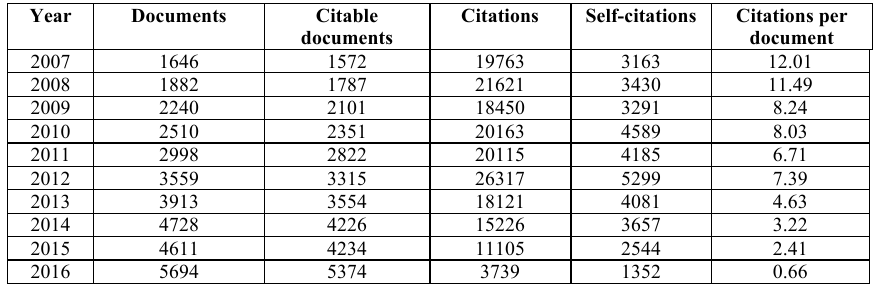
Table 1. Evolution of scientific production in Morocco from 2007 to 2015